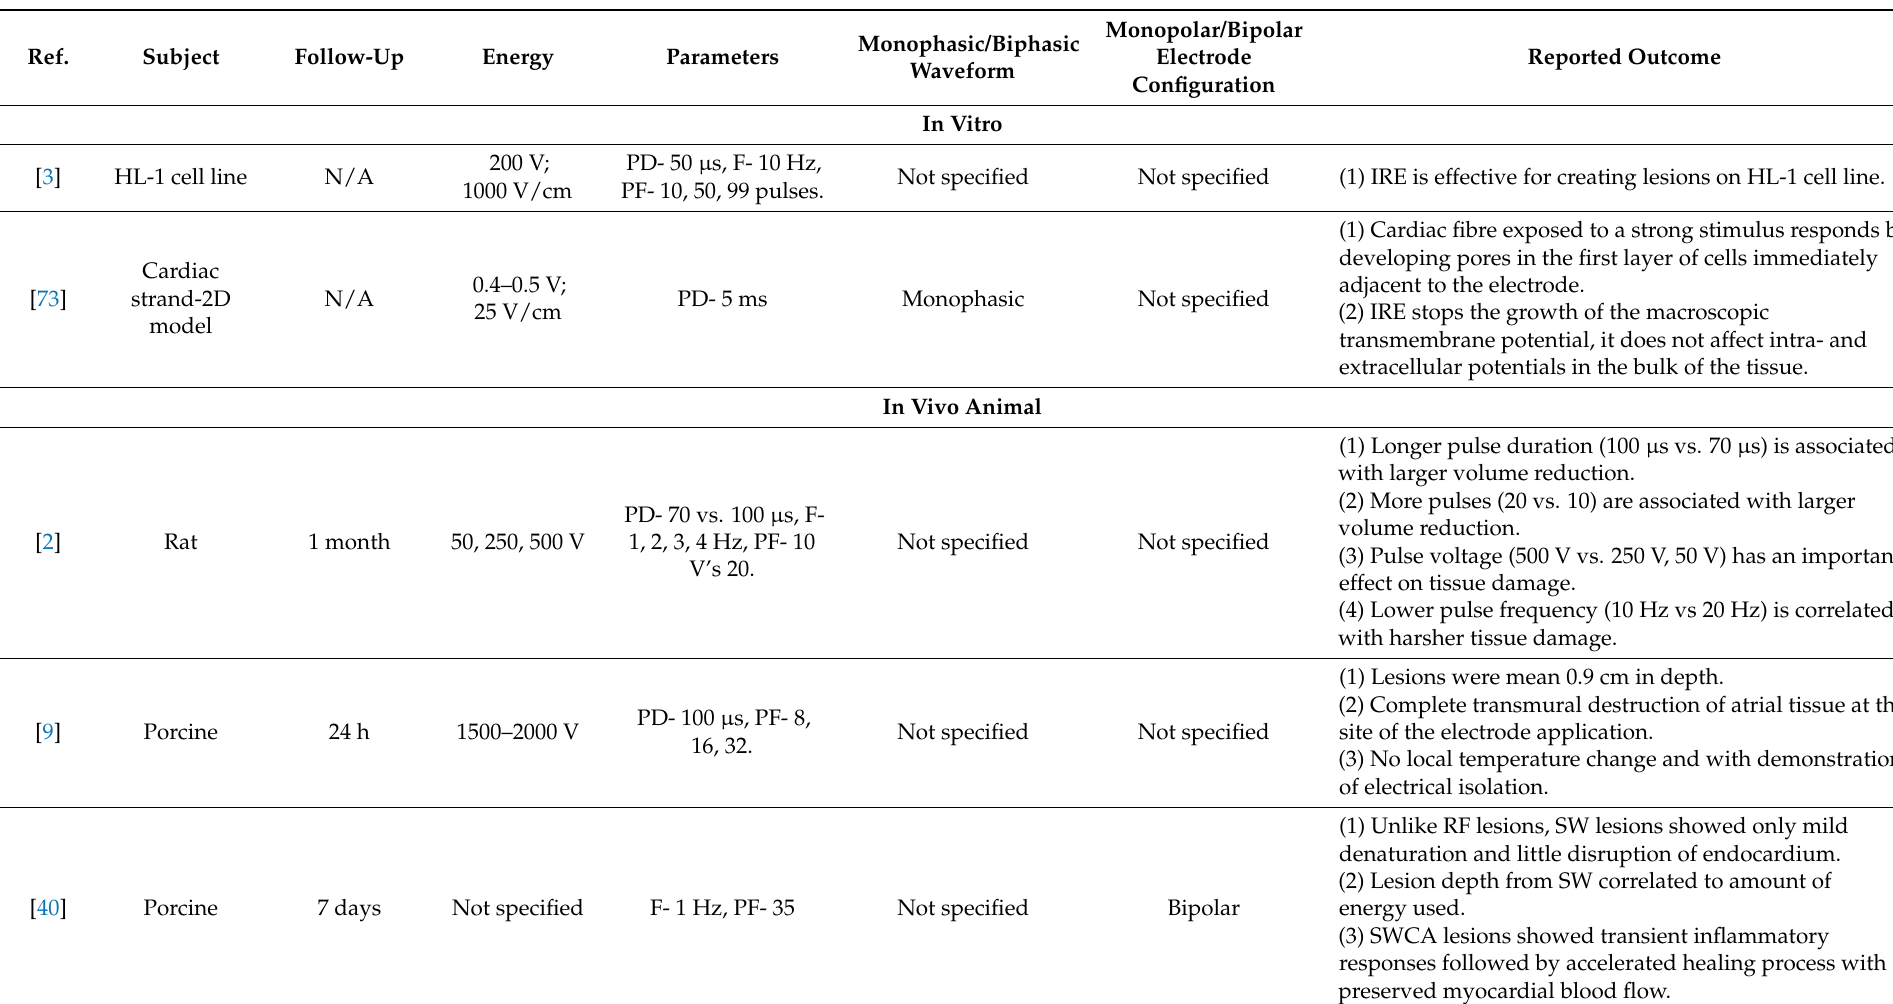
Table 2. Comparison of preclinical IRE studies on cardiac